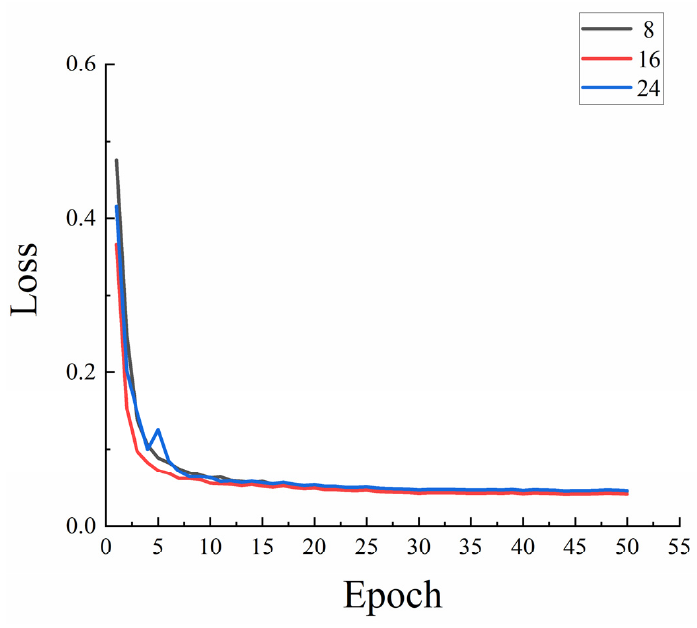
Figure 6. The effect of batch size on model performance. Figure 6. The e ff ect of batch size on model performance.